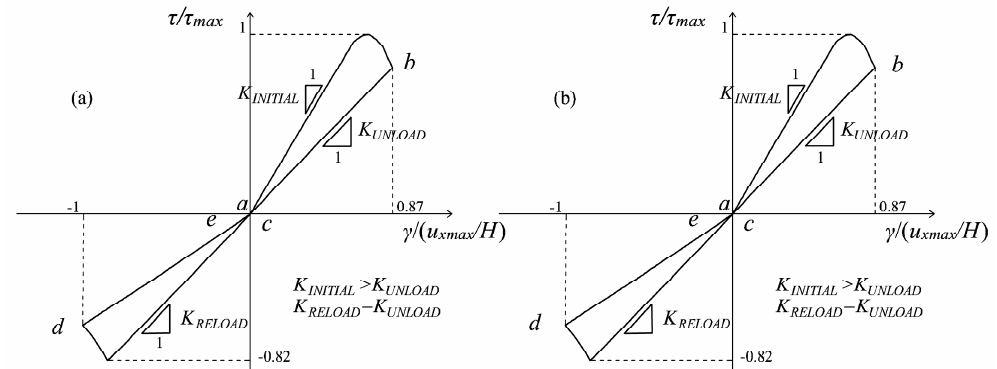
Figure 9. Structural response for the problem represented in Figure 5a, ratio m = 1: ( a ) damage formulation presented in Section 2 and ( b ) multidirectional damage model.